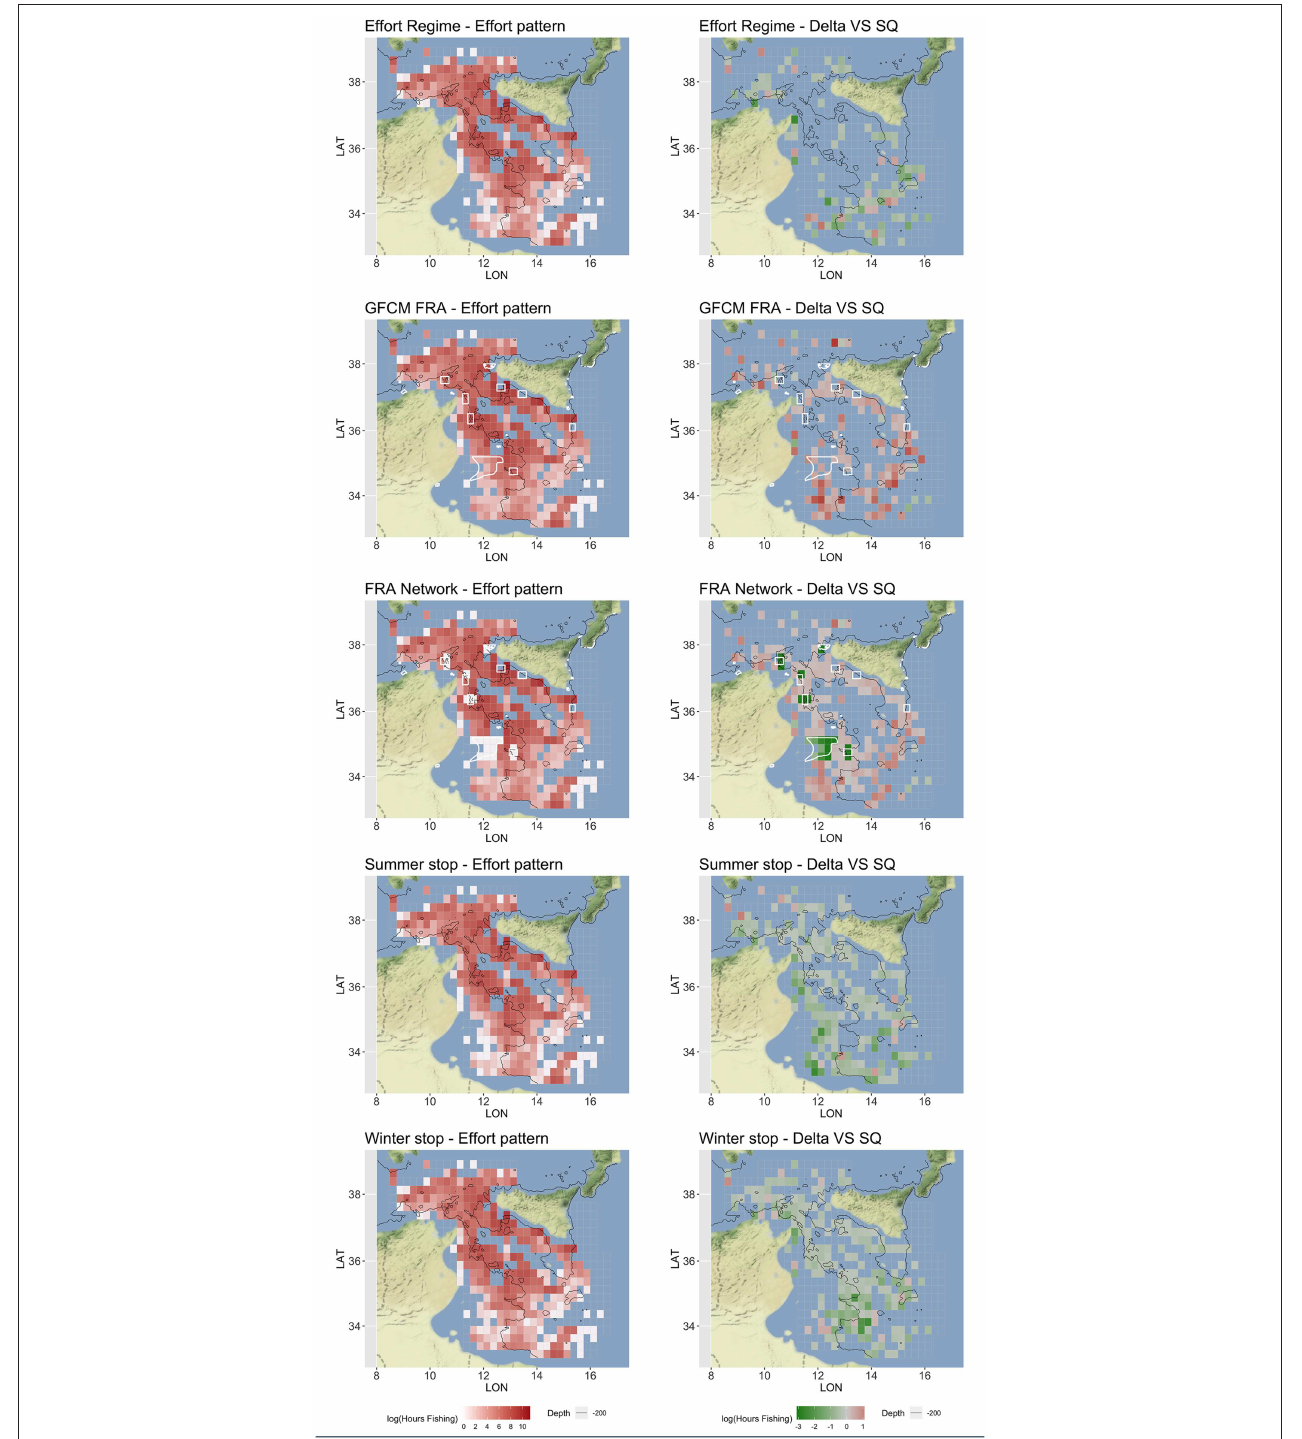
FIGURE 7 | Optimized (mean over 100 simulations) fishing effort pattern, represented in red scale of Log Hours Fishing, and corresponding for the difference (Delta) with respect to the status quo (SQ), represented in green-red scale of Log Fishing Hours, for each scenario. The FRAs are represented as white polygon in the Spatial-based scenarios. These patterns represent the total yearly fishing effort for the Italian trawlers operating in the SoS. Figures were created using the R package ggmap (Kahle and Wickham, 2013) using Map tiles by Stamen Design, under CC BY 3.0 and data by OpenStreetMap contributors (2017).